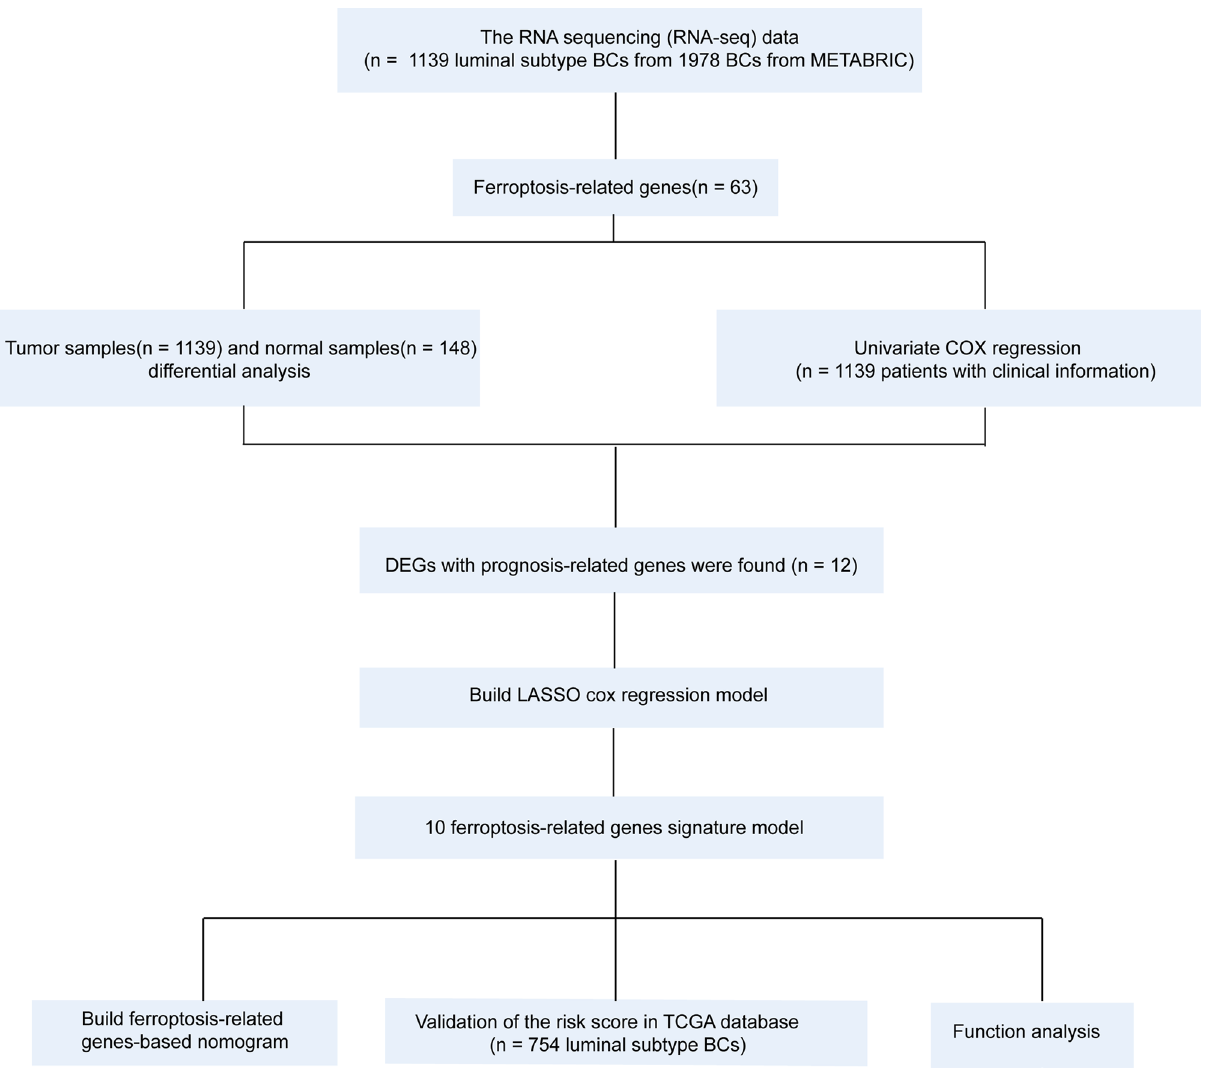
Figure 1. Study flow chart of the collection and analysis of data from the METABRIC and TCGA